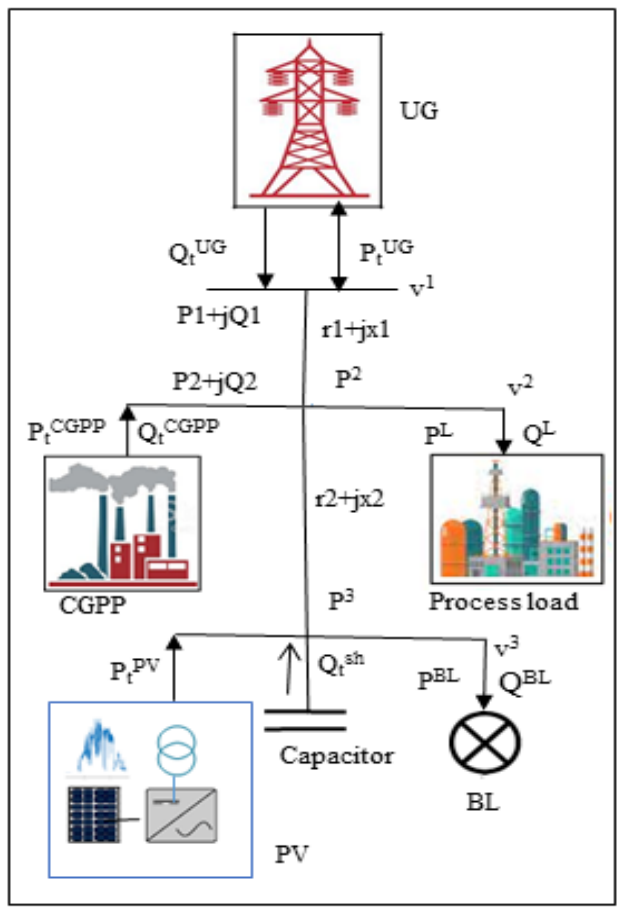
Figure 5. Schematic diagram of the CGPP integrated with the SPP.